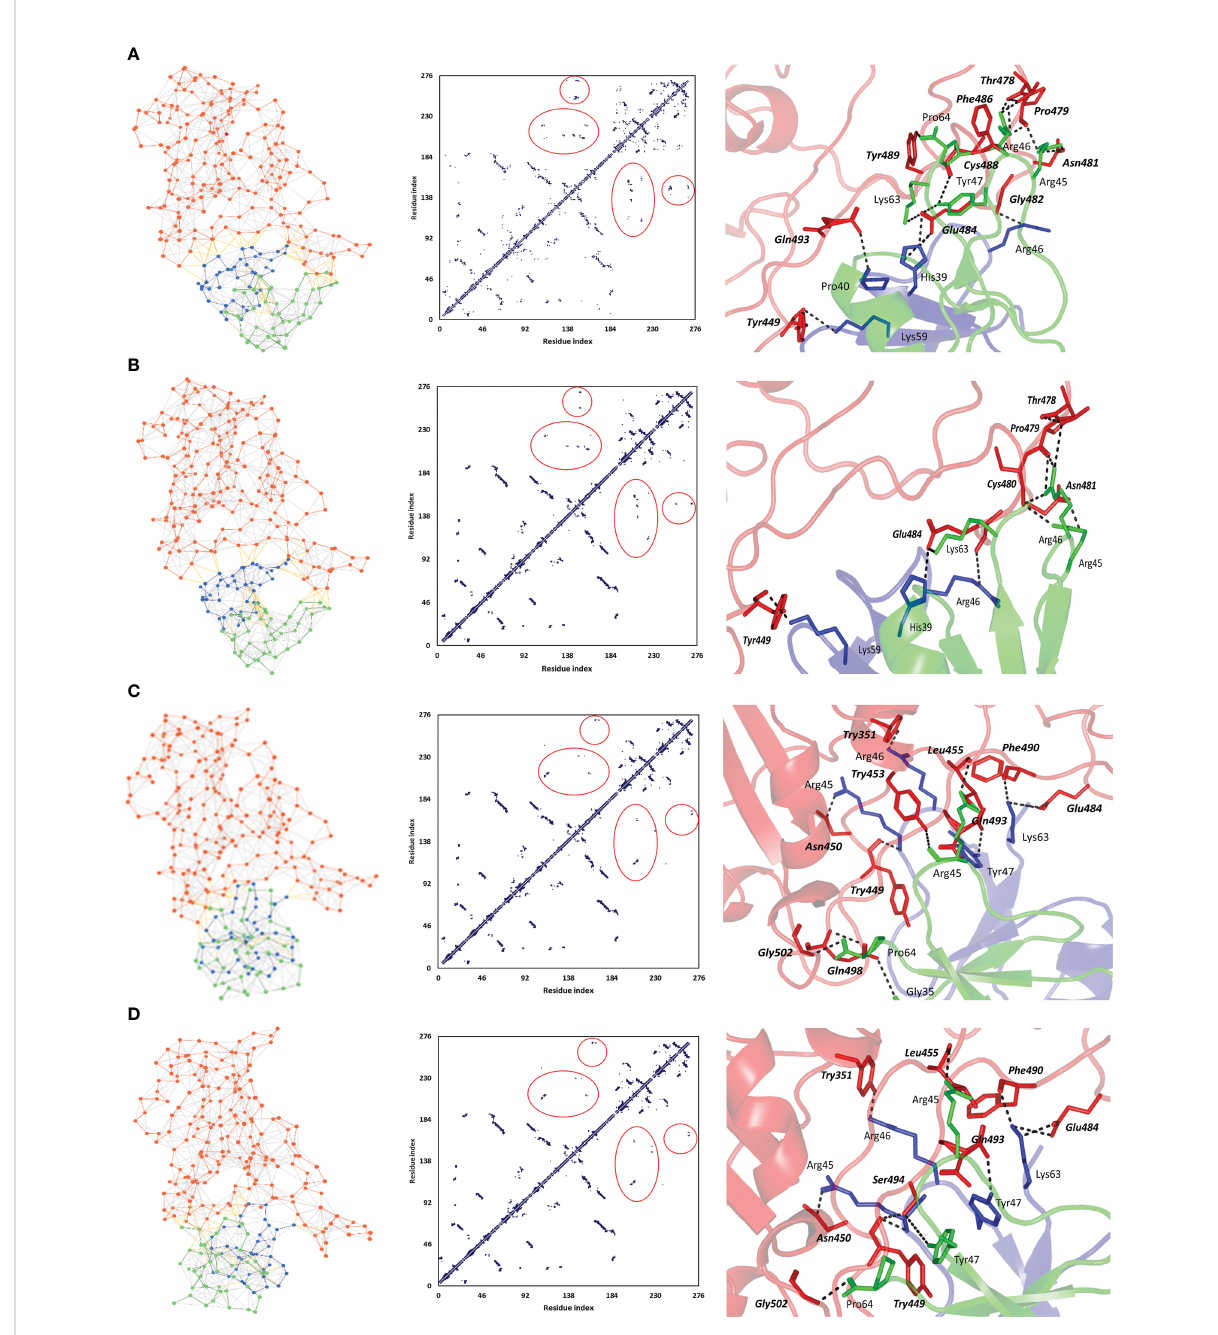
FIGURE 4 Interface analysis for the ZDOCK-obtained spike RBD/ h BD-2 dimer complexes using NASP sever. (A) Native h BD-2 model, (B) SNP1 h BD-2 mutant model, (C) SNP2 h BD-2 mutant model, and (D) SNP3 h BD-2 mutant model. Left panels illustrate the network between edges (inter-/ intra-molecular bonds as yellow and gray colors, respectively) and dots/nodes (amino acids; orange for spike RBD and blue/green for the h BD- 2 dimers). The middle panels illustrate the contact plots for the residue – residue interactions between the monomeric units of spike RBD (residue index 1 – 194) and h BD-2 (residue index 195 – 276). Circle highlights are shown to pinpoint the contact interfacing residues between spike RBD and h BD-2 proteins, as well as h BD-2 protein monomers. Right panels illustrate the interface key polar interactions as predicted by the PDBePISA docking server. Protein backbones are depicted as a transparent cartoon colored red, blue, and green for spike RBD, h BD-2 protomer A, and h BD-2 protomer B, respectively. Key residue pairs are presented as lines, colored depending on their location within the proteins, and numbered according to their respective residue sequence. Spike RBD residues are presented in bold and italic. Bonds of polar interactions are black dashed